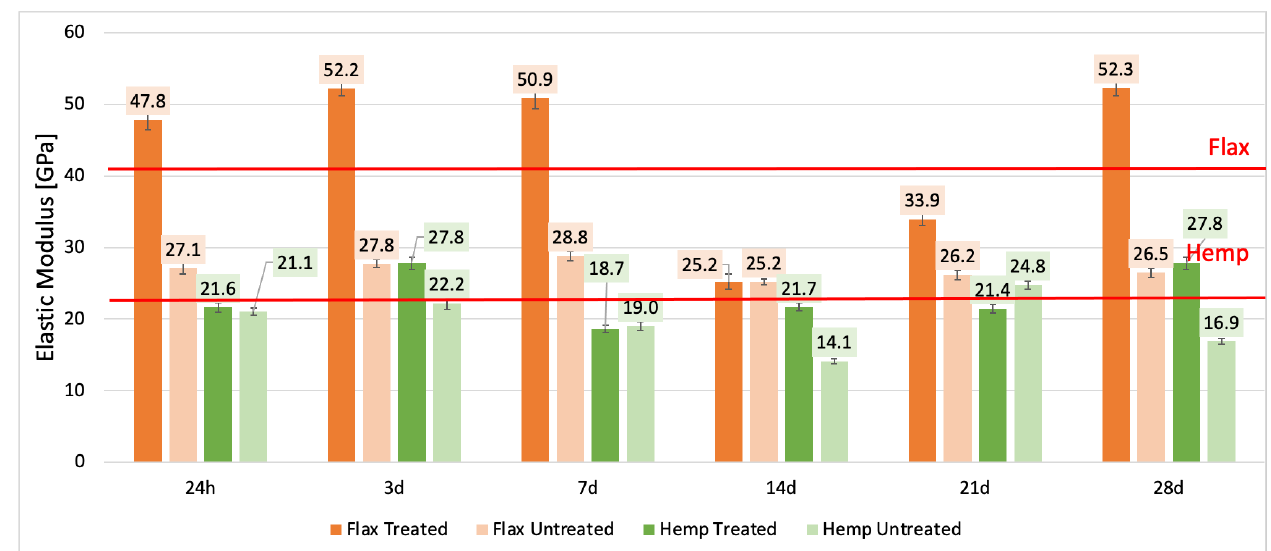
Figure 13. Effects of the degradation at an alkaline solution on the tensile strength.